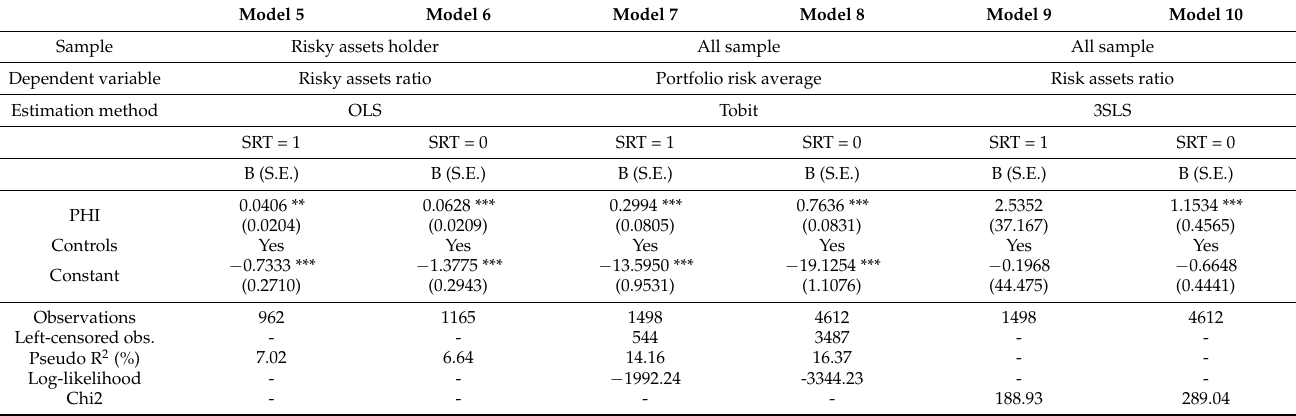
Table A3. Private health insurance and risk taking in Spain.